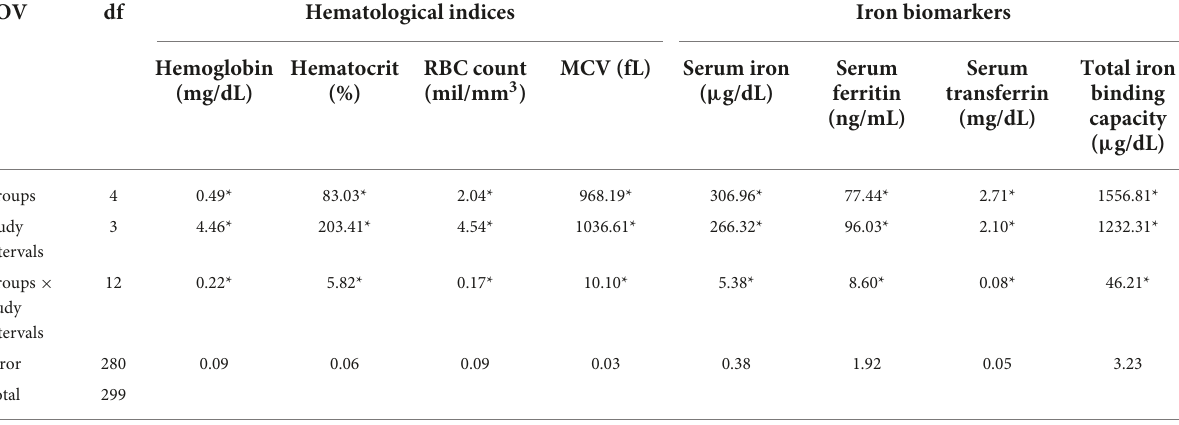
TABLE 2 Mean squares regarding hematological indices and iron biomarkers for anemic women fed with prebiotic and iron fortified diet. SOV